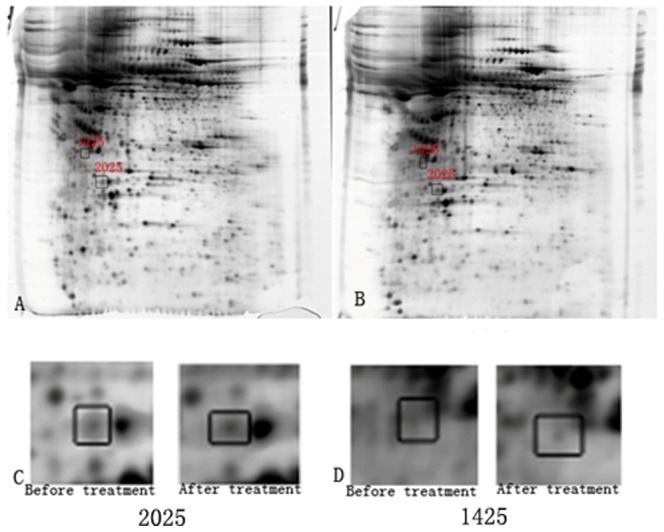
Plasma APOA-1 and GNAS expression before and after risperidone treatment using 2-DE.A: APOA-1 (spot ID 2025) and GNAS (spot ID 1425) expression before treatment. B: APOA-1 (spot ID 2025) and GNAS (spot ID 1425) expression after treatment. C: Plasma level of APOA-1 (spot ID 2025) was significantly increased after 8 weeks of risperidone treatment. D: Plasma level of GNAS (spot ID 1425) was significantly reduced after 8 weeks of risperidone treatment.